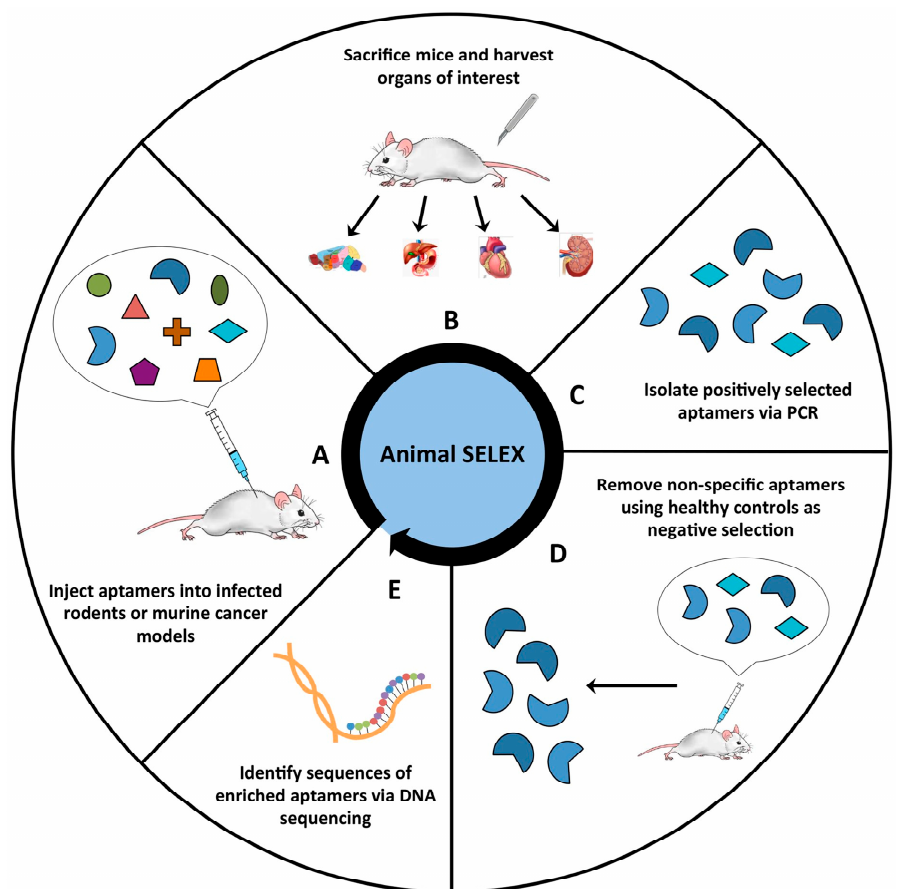
Figure 2. Flowchart of animal SELEX. Animal SELEX can be used to generate aptamers specific to target tissues. ( A ) Aptamer libraries are first injected into the target mice. ( B ) After inoculation, the organs of interest are harvested. ( C ) The selected aptamers are isolated and amplified by PCR. ( D ) After rounds of selection, counter selection can be performed by inoculating aptamer pool into the healthy mouse tissues. ( E ) The aptamer sequences with high affinity and specificity to the target tissues of interest are selected and identified by sequencing.